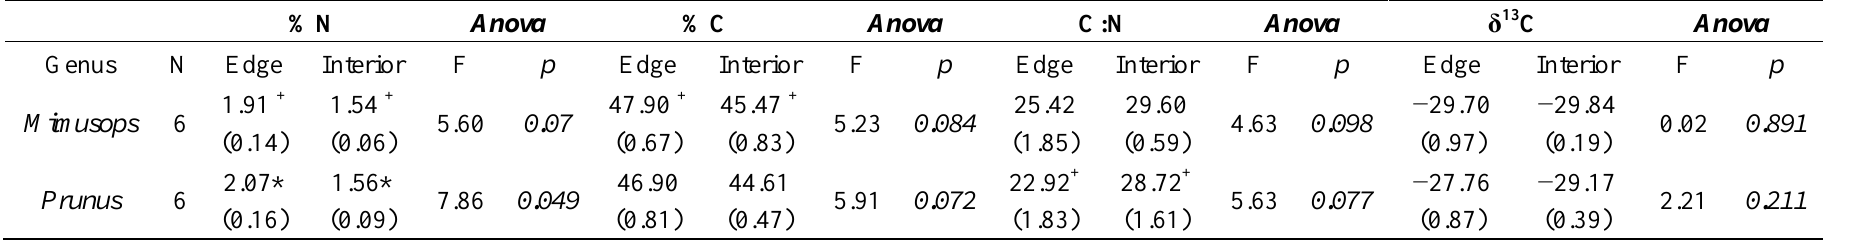
Table 2. The mean (±1 SE) percent nitrogen (%N), carbon (%C), C:N ratio, and the stable isotope C of foliar samples collected from trees ( Mimusops and Prunus ) from the edge and interior of two forest fragments in northern Ethiopia. A one-way ANOVA was conducted within sites between edge and